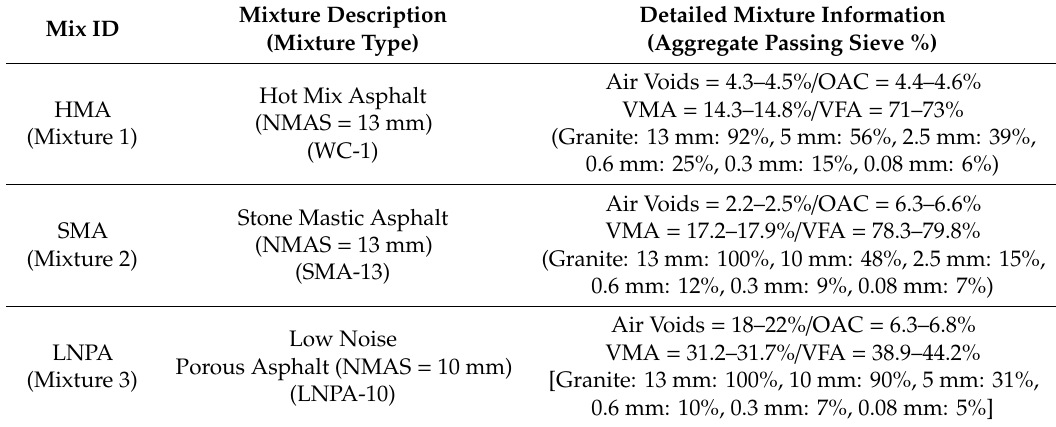
Table 1. Mix design of the asphalt mixtures.